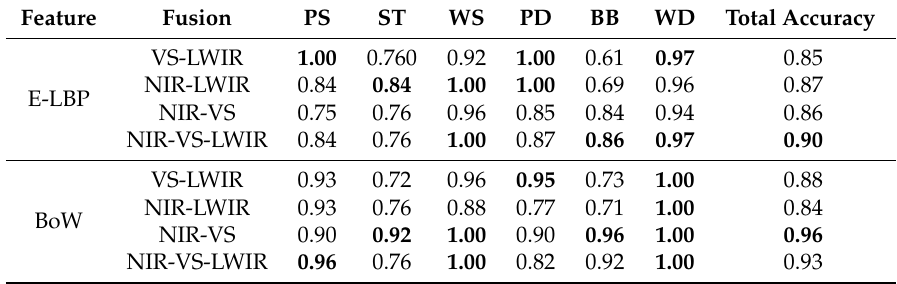
Table 3. Classification performance using E-LBP/BoW and naive early fusion (PS = Paper scraps, ST = Stains, WS = White spots, PD = Paper displacements, and BB = Bubbles, WD = Without defect). Feature Fusion PS